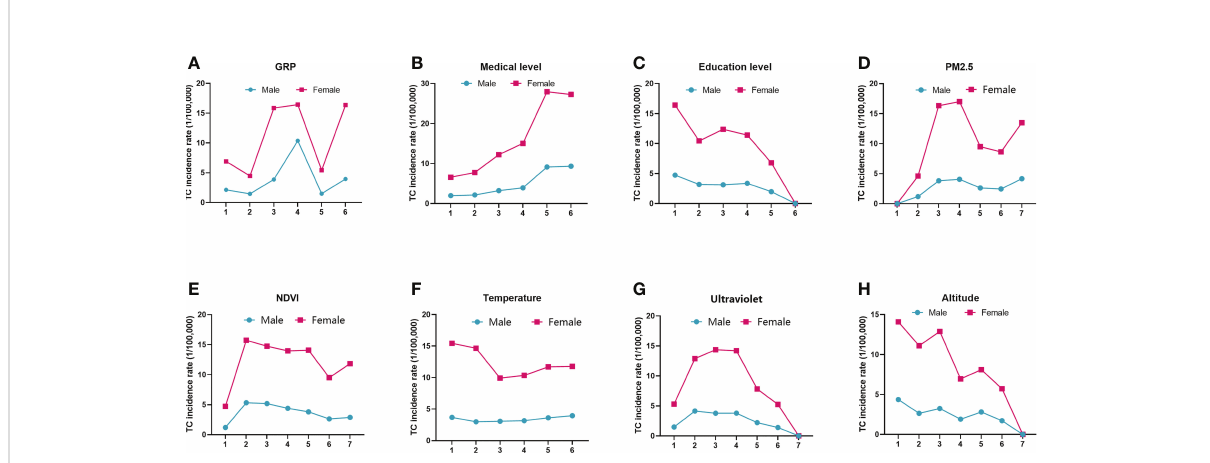
FIGURE 5 Spatial distributions of thyroid cancer incidence rates in different intervals of eight factors. The intervals of each factor are given along the horizontal axis. The vertical axis represents the thyroid cancer incidence rate (1/10 5 ). Solid dots and squares are the average thyroid cancer incidence rates in the different subtypes of the eight factors. Green and magenta colors represent men and women, respectively. (A) GRP, gross regional product; (B) medical level; (C) education level; (D) PM2.5, fi ne particulate matter; (E) NDVI, normalized difference vegetation index; (F) temperature; (G) ultraviolet; (H)